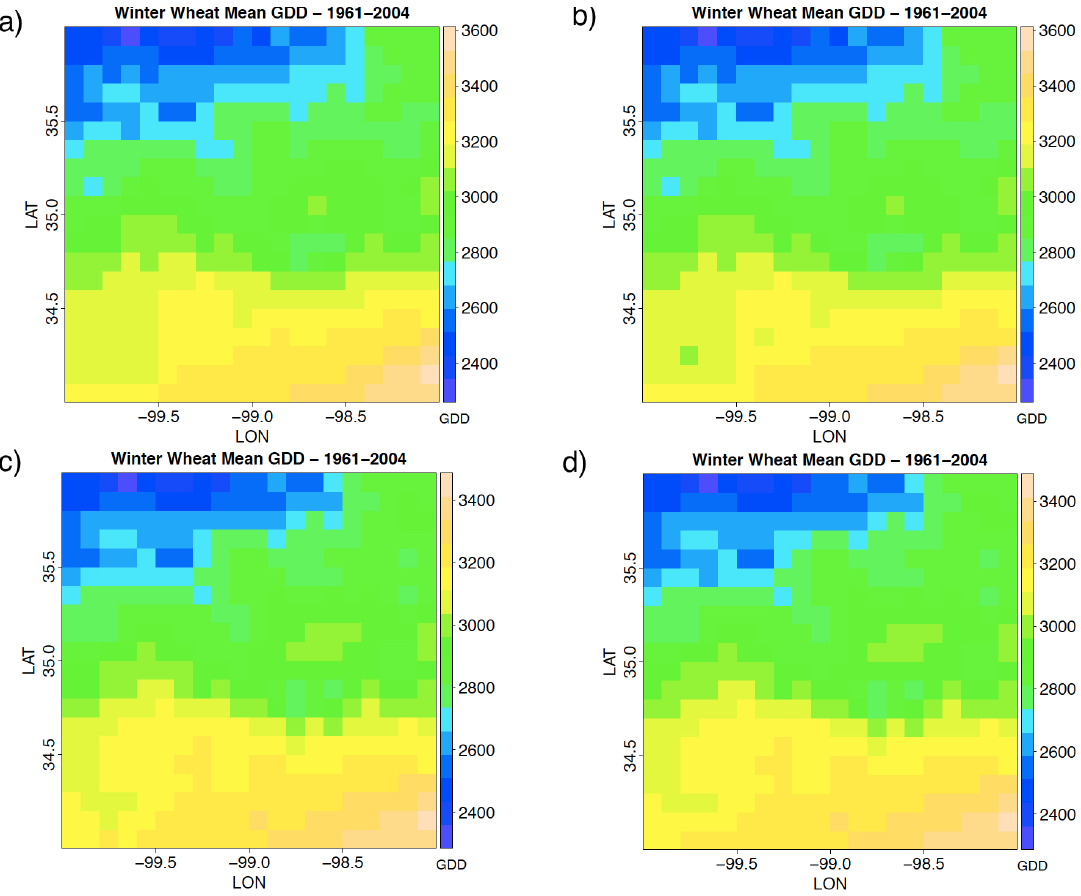
Figure 4. Mean Growing Degree Days derived from the Global Climate Model (GCM) historical runs (1961–2004) and four GCM/downscaling model combinations: ( a ) outputs for the CCSM4 GCM and Cumulative Density Function transfer (CDFt) downscaling method. ( b ) outputs for the CCSM4 GCM and the Equidistant Quantile Mapping (EDQM) downscaling method. ( c ) outputs for the MIROC5 GCM and CDFt downscaling method. ( d ) outputs for the MIROC5 GCM and EDQM downscaling method.